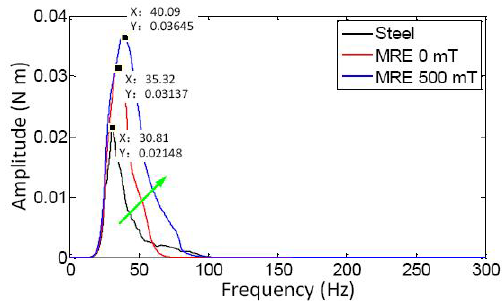
Figure 18. Natural frequencies of three